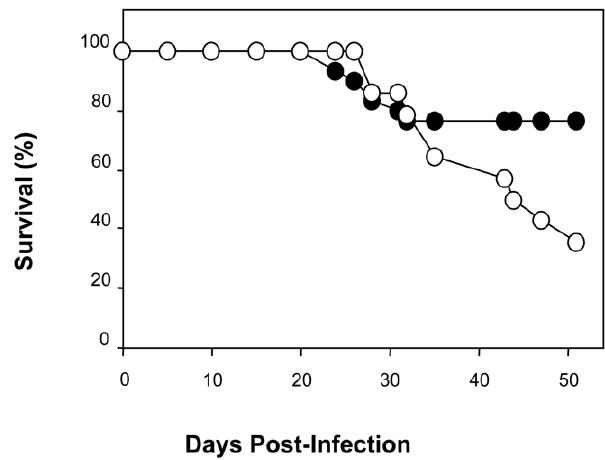
Figure 7. Treatment of T.cruzi infected COX-1 null mice with N ASA increases mortality. Survival curves for COX-1 null mice treated ; n=10) or ASA (20 mg/kg) ( # ; n=14) beginning on with vehicle ( 5 dpi. Mice were inoculated with 10 4 trypomastigotes of the Brazil strain and observed over 50 dpi.